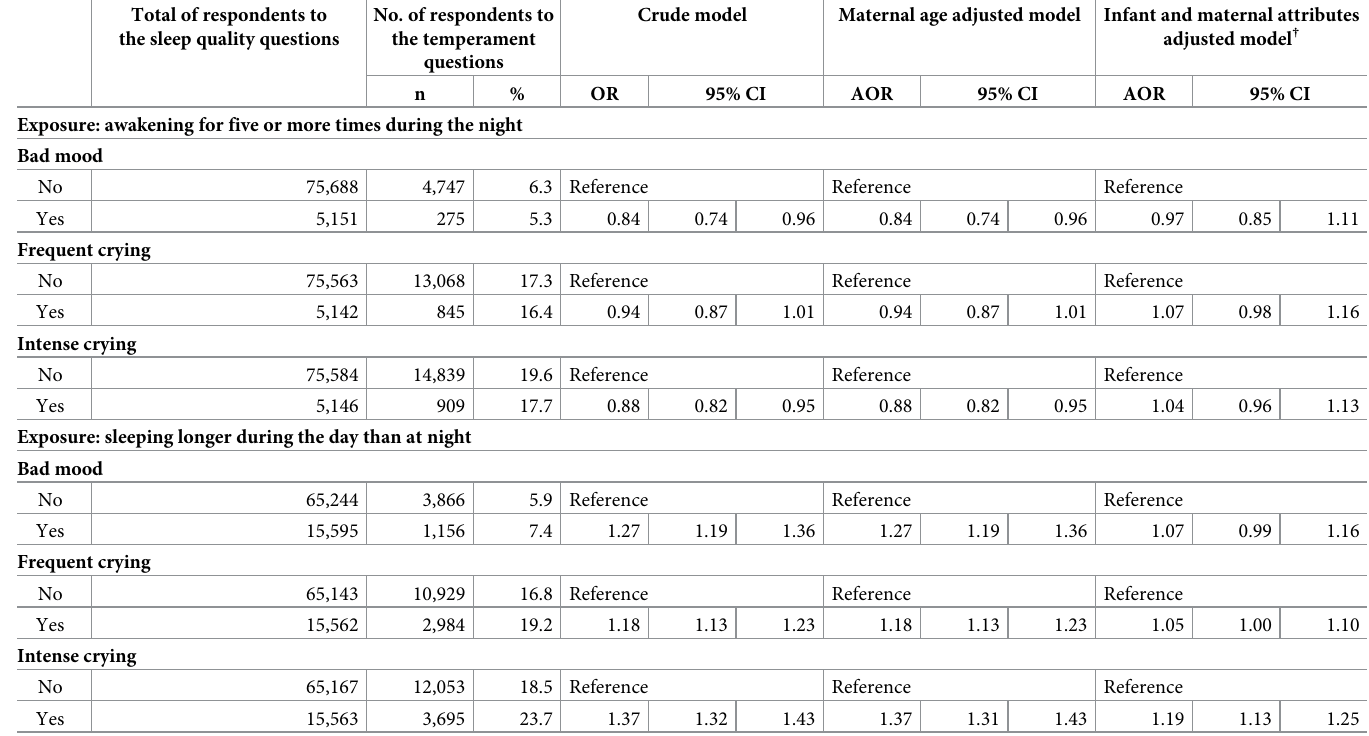
Table 3. Logistic regression analysis of association of infant sleep quality with temperament in one-month-olds. Total of respondents to the sleep quality